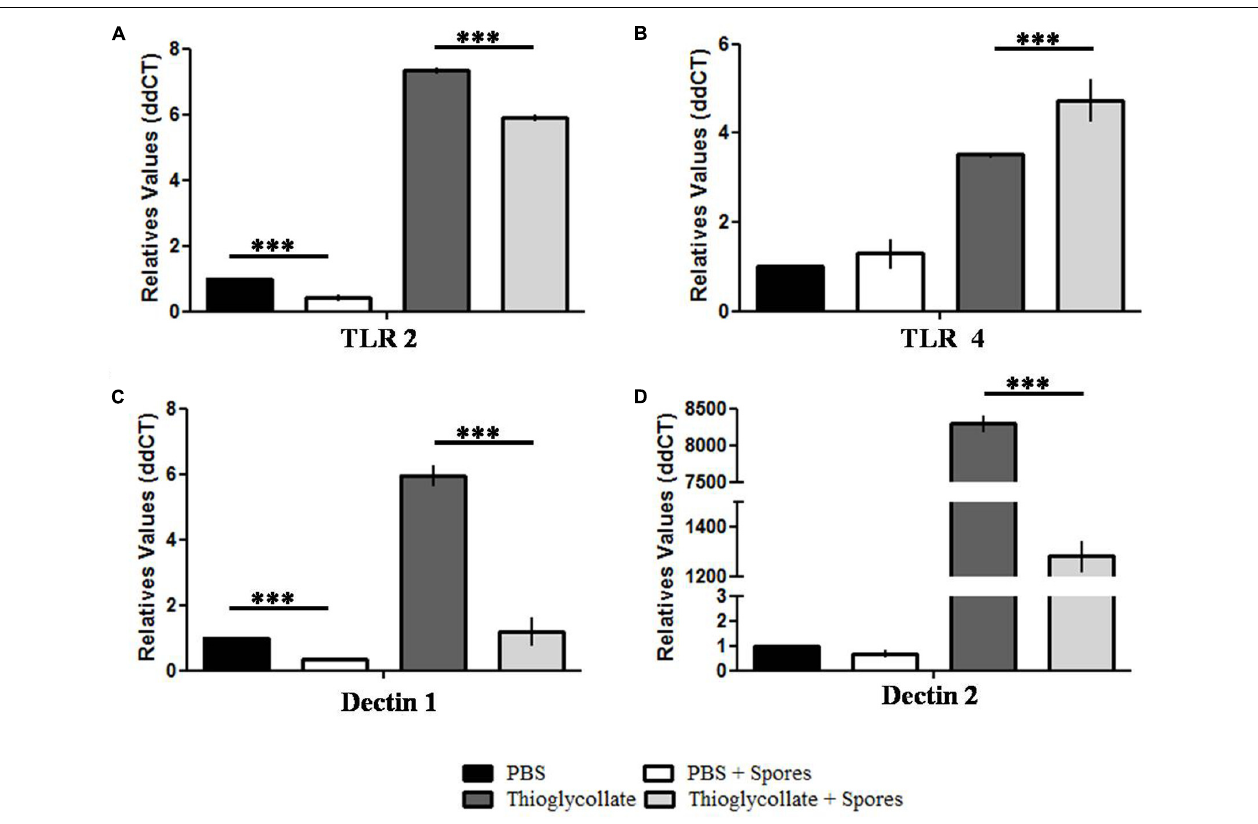
FIGURE 7 | Surface receptors gene expression profile from C57BL/6 mice peritoneal macrophages. Analysis of relative expression of (A) TLR2, (B) TLR4, (C) dectin-1 and (D) dectin-2 obtained from C57BL/6 mice peritoneal macrophages exposed or not to T. asperelloides spores. Values were obtained by qPCR using two biological replicates from three different experiments. The relative expression was calculated using the 2 − (cid:49)(cid:49) C t methodology (Livak and Schmittgen, 2001) and values were normalized with the 18S gene. Bars represent mean + SE ( n = 6). ∗∗∗ p ≤ 0.0005 compared to control group by Tukey post-test. Results represent data obtained from three independent experiments with three mice in each